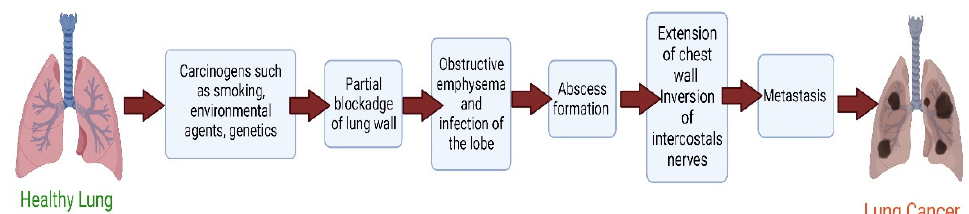
Figure 1. Pathophysiology of lung cancer.